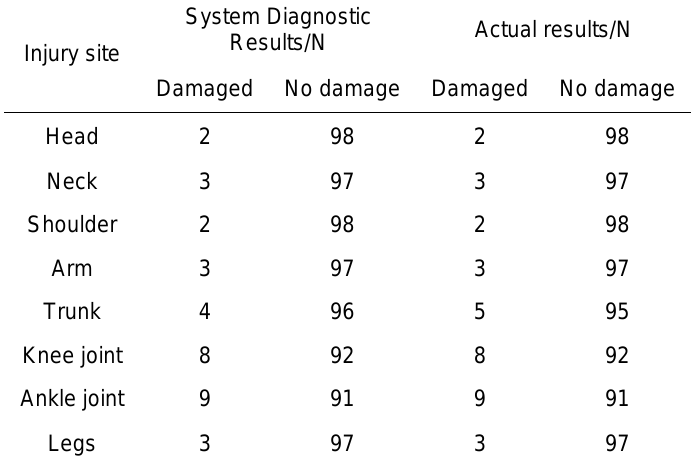
Table 4. Temperature collection results of martial arts athletes